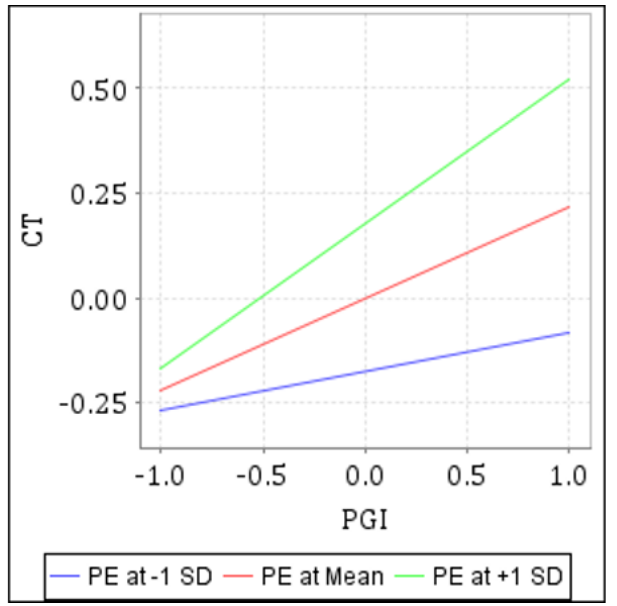
Figure 3. Moderating effect of patient expertise (PE) on cognitive trust (CT) by patient-generated information